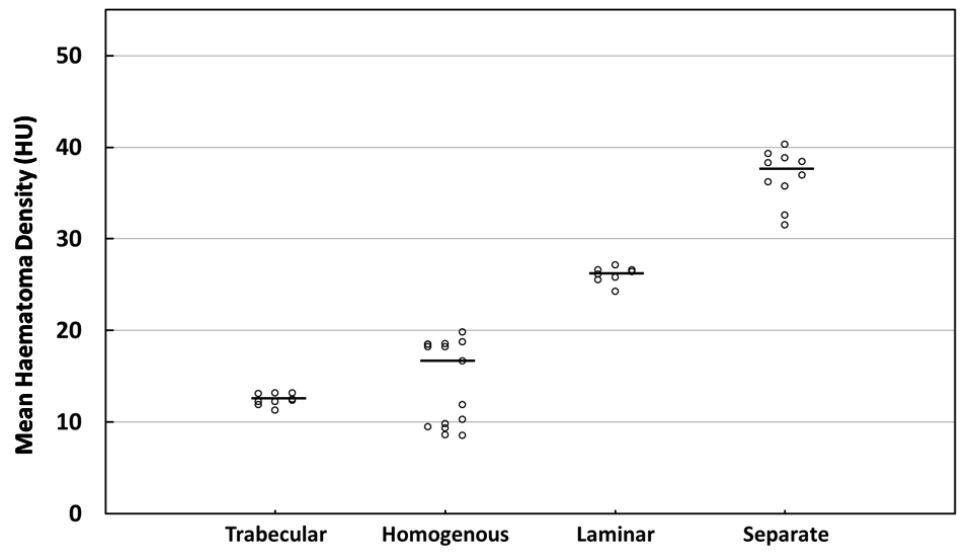
Figure 3. The distribution of MHD across four types of CSDHs based on internal structure. The dots indicated individual observations and the horizontal bar represents the median.